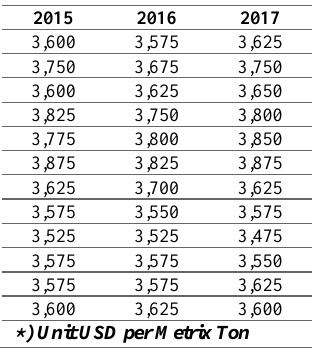
Table 5. Data interval